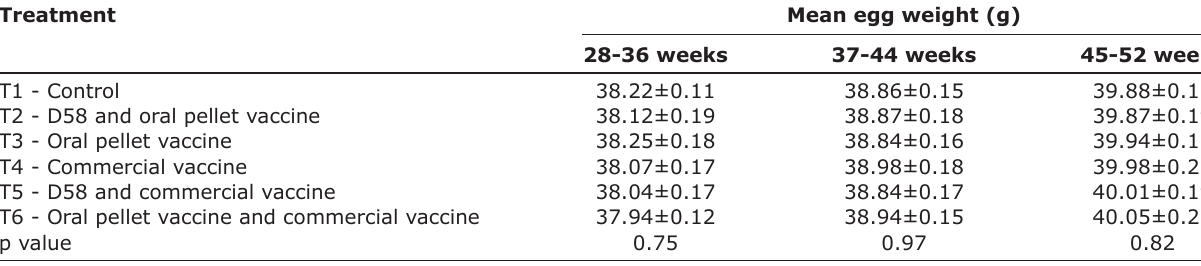
Table-2: Effect of different ND vaccine and vaccination regimen in desi chicken on egg weight (g) (mean±SE). Treatment